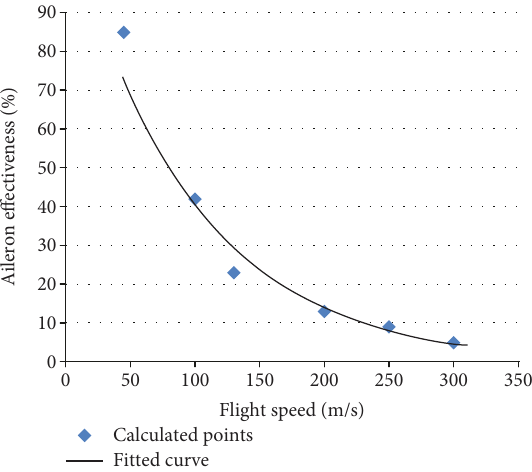
Figure 2: Aileron e ff ectiveness vs. fl ight speed.